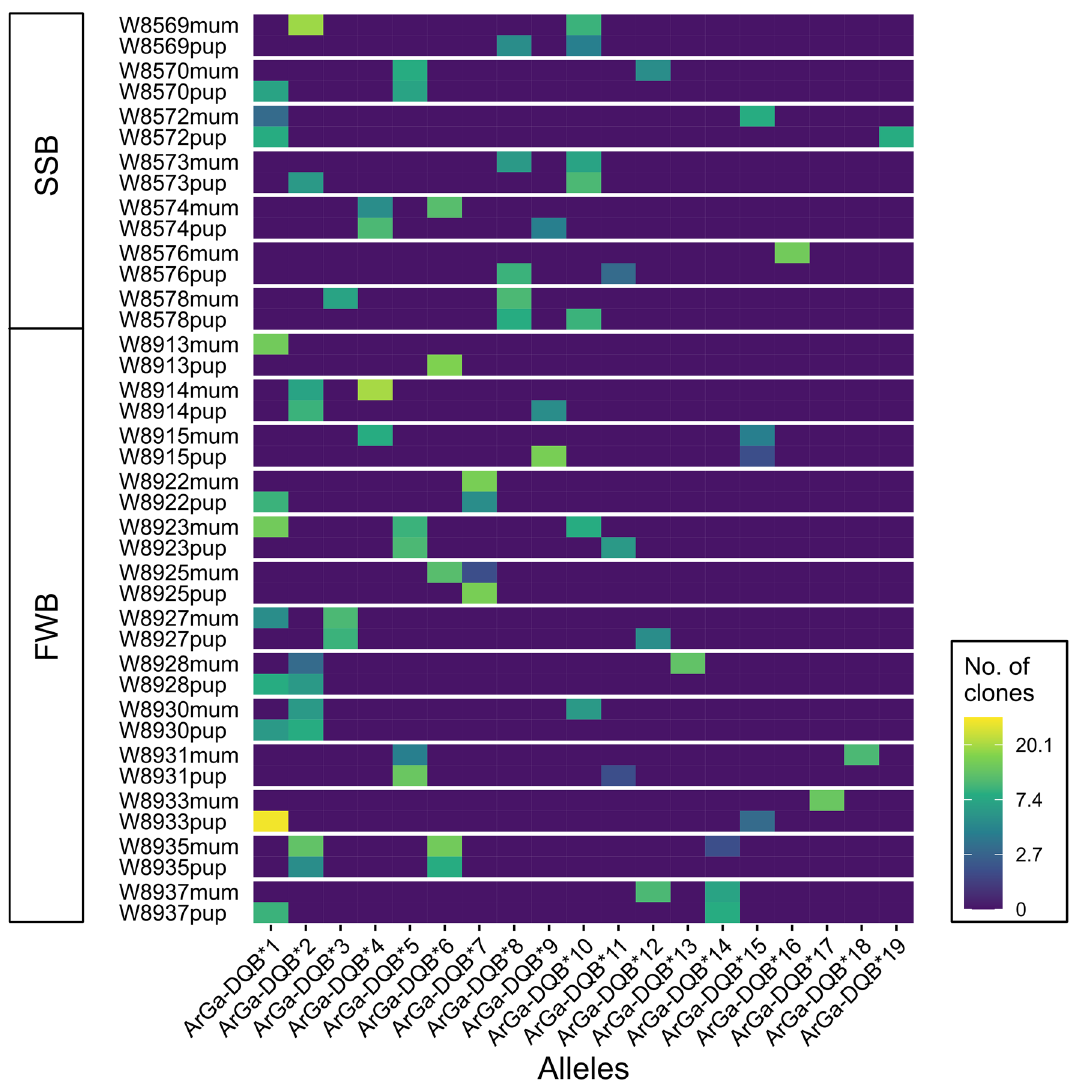
Figure 3. Heatmap depicting the MHC genotypes of 20 Antarctic fur seal mother–offspring pairs from SSB (top) and FWB (bottom). The alleles are colour coded according to the number of clone sequences of that allele obtained for each individual.